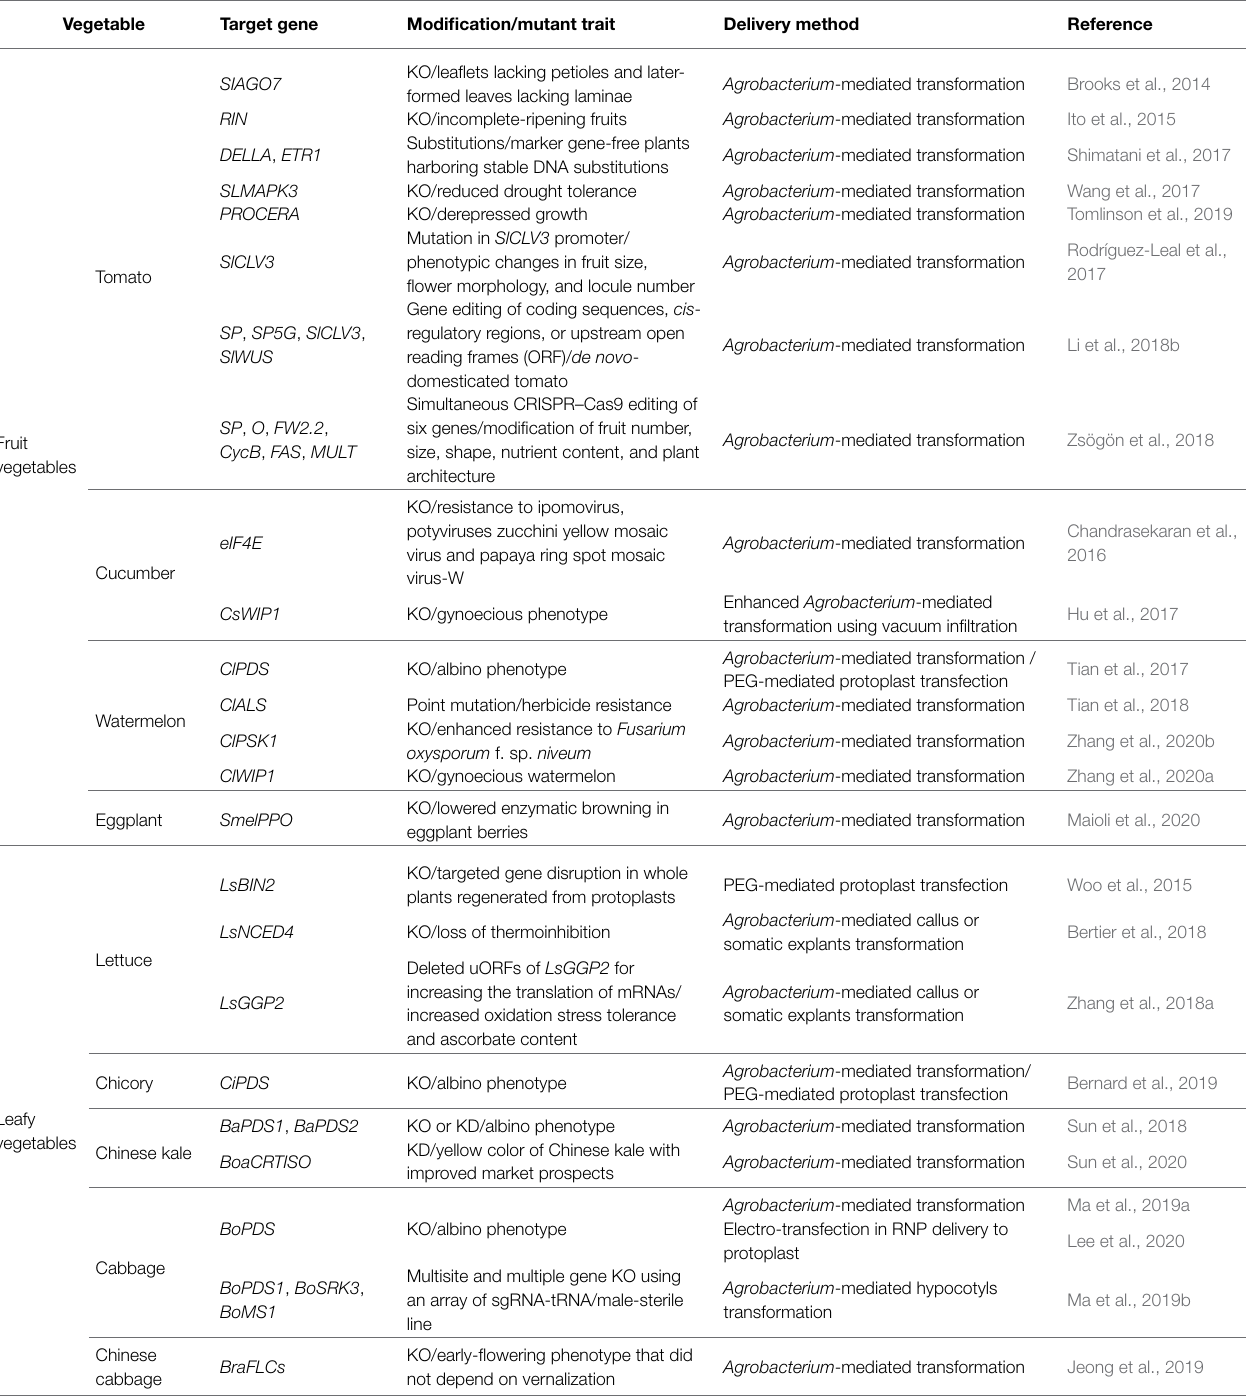
TABLE 1 | Application of CRISPR-Cas9-based editing of genes in vegetables.